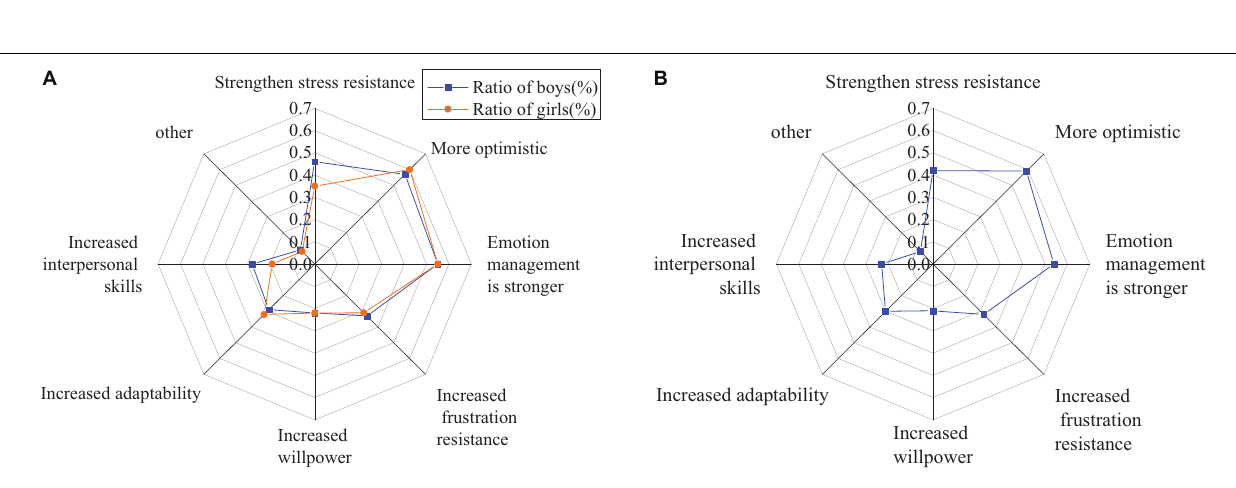
Frontiers in Psychology |